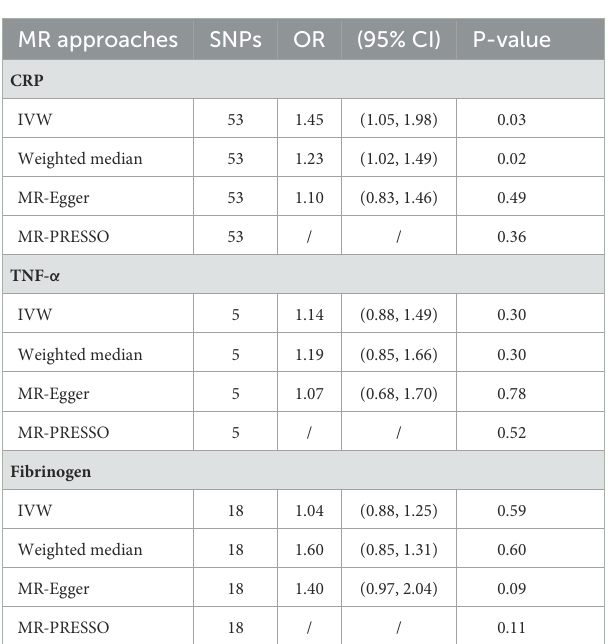
hypotheses. MR-Egger analyses allow for pleiotropy for all genetic TABLE 1 MR analyses showing the associations of genetically Inflammatory markers with the Risk of